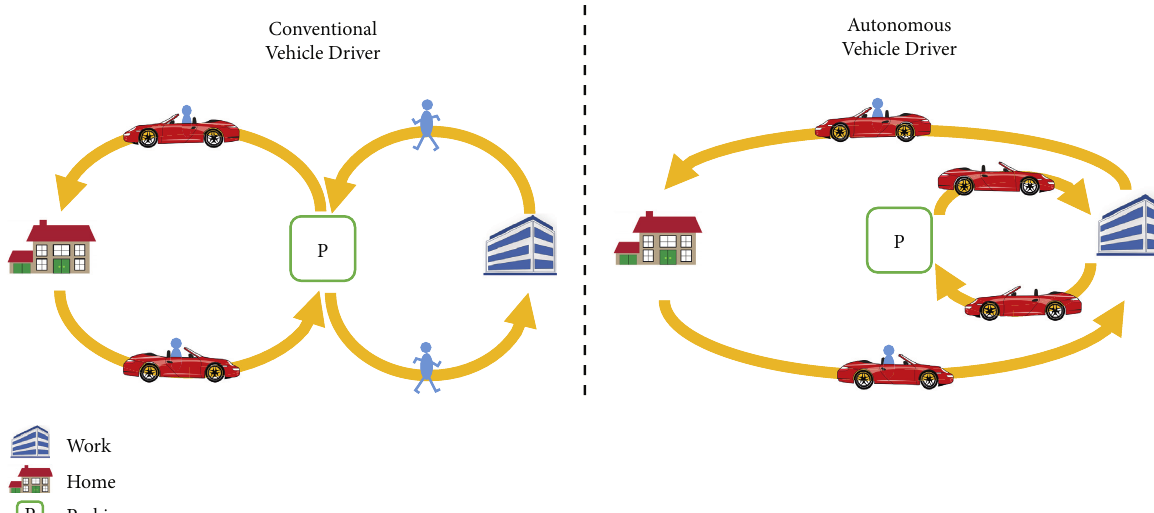
Figure 1: Parking pattern of autonomous and conventional vehicle